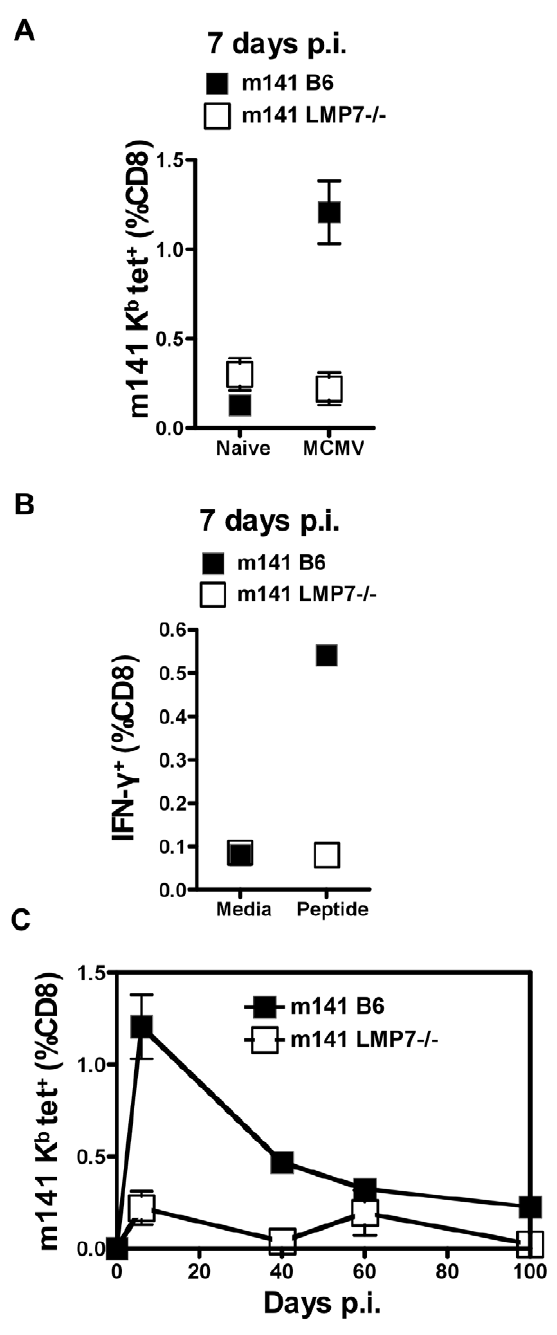
Figure 2. CD8 + T cell responses to m141 in LMP7 2 / 2 mice infected with MCMV. A. Lymphocytes were prepared from peripheral blood of LMP7 2 / 2 and C57BL/6 control mice 7 days p.i. (n=3) or PBS treated (n=2) and subjected to tetramer stain and FACS analysis as for Figure 1A, using MCMV m141 tetramer (H-2 K b 15 VIDASFRL 23 ). The plot shows the frequency of m141 K b -specific cells among CD8 + T cells. B. Splenocytes were prepared from spleens of LMP7 2 / 2 and C57BL/6 control mice 7 days p.i. (n=6), pooled, and incubated in the presence of BFA with either media containing peptide VIDAFSRL or media alone for 5 hours. Cells were stained as in Figure 1C and analysed by FACS. The plot shows % CD8 + T cells producing IFN- c in response to peptide or media alone. C. Peripheral blood was sampled from LMP7 2 / 2 and C57BL/ 6 control mice (n=3) at 7, 40, 60 and 100 days p.i. and subjected to tetramer stain and FACS analysis as for A. The plot shows the